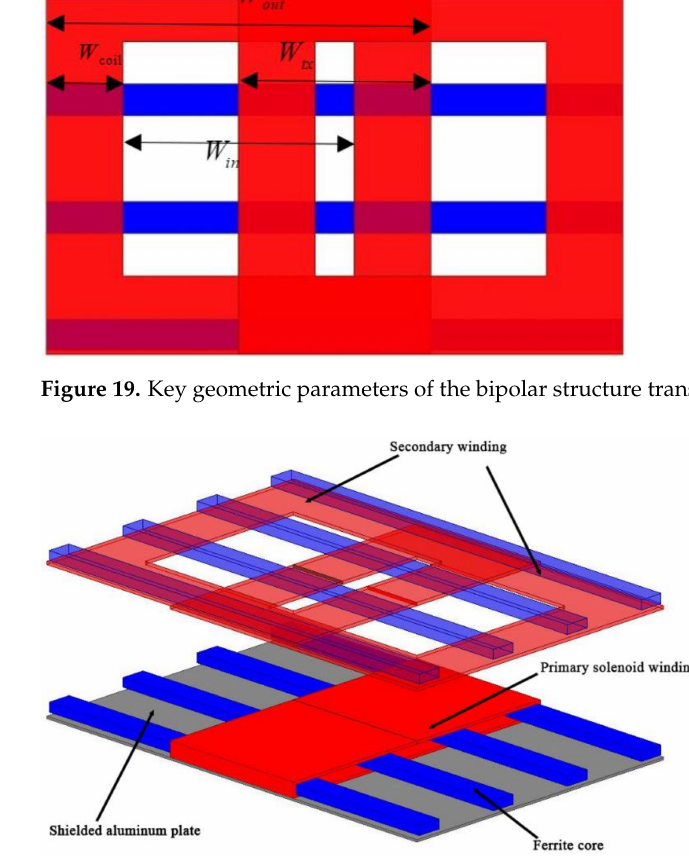
Figure 20. System architecture of the transformer in 3-D.